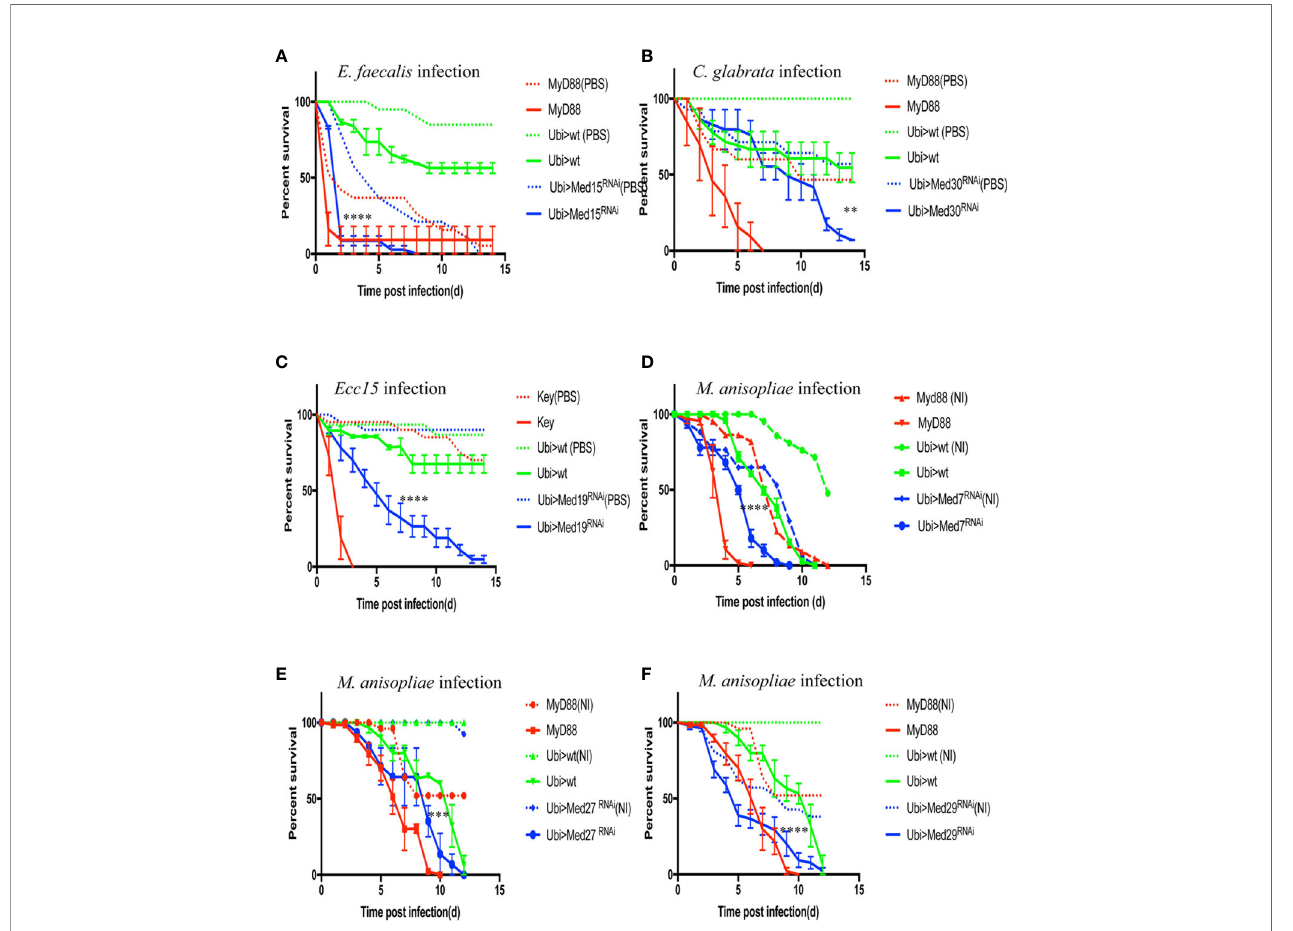
FIGURE 6 | Survival of RNAi fl ies targeting different Mediator complex subunits after challenge with various pathogens. Survival of other Mediator complex subunits RNAi lines after challenges with either E. faecalis , C. glabrata , Ecc15 , or M. robertsii. MyD88 was used as positive control line (red) for M. robertsii , C. glabrata or E. faecalis infection, and key was the positive control line (red) for lines infected with Ecc15 . Ubi> mCherry RNAi line was the wild type control line (green) and Ubi> RNAi line of Mediator complex subunits is displayed in blue. (A) Survival curves of Med17 RNAi fl ies, which were susceptible to E. faecalis infection. Infected Med17 RNAi fl ies vs. infected mCherry RNAi fl ies: log-rank test, ****P < 0.0001. The survival curves are representative of six experiments. (B) Med30 RNAi fl ies were susceptible to C. glabrata infection. Infected Med30 RNAi fl ies vs. infected mCherry RNAi fl ies: log-rank test, **P < 0.01. The survival curves are representative of two experiments. (C) Med19 RNAi fl ies were susceptible to Ecc15 infection. Infected Med19 RNAi fl ies vs. infected mCherry RNAi fl ies: log-rank test, ****P < 0.0001. The survival curves are representative of two experiments. (D – F) Med7 , Med27 , and Med29 RNAi displayed an enhanced sensitivity to M. robertsii “ natural ” infection. Infected Med7 RNAi fl ies vs. infected mCherry RNAi fl ies: log-rank test, ****P < 0.0001. The survival curves are representative of three experiments. Infected Med27 RNAi fl ies vs. infected mCherry RNAi fl ies: log-rank test, ***P < 0.001. The survival curves are representative of two experiments. Infected Med29 RNAi fl ies vs. infected mCherry fl ies: log-rank test, ****P < 0.0001. The survival curves are representative of two experiments. Please, note that the mock-infected fl ies for Med7 and Med29 succumbed also rapidly to the procedure, making it dif fi cult to conclude unambiguously on the role of these two subunits in the host defense against M. robertsii “ natural ” infection. Error bars are